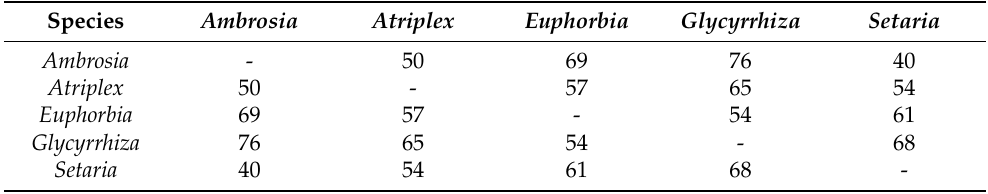
Figure 6. Boxplot of VIs MPRI, Gitelson, Carter6 and ClAInt for Ambrosia artemisiifolia , Atriplex tatarica , Glycyrrhiza glabra , Euphorbia seguieriana , and Setaria pumila . The VIs group, the average values of which significantly differed in the compared species according to an independent two-sample t -test, is presented in Tables 3, 4 and S3. Table 3. Significantly different VIs between compared pairs of species according to an independent two-sample t -test.